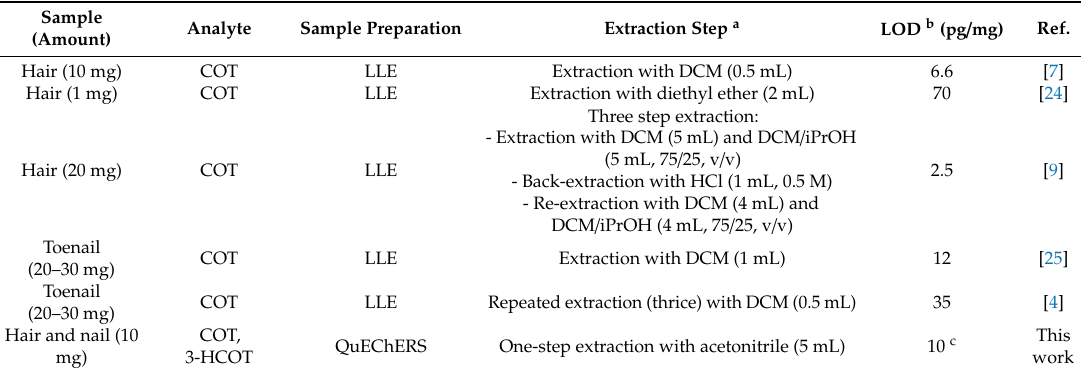
Table 4. Comparison of the proposed method with other methods for the detection of nicotine